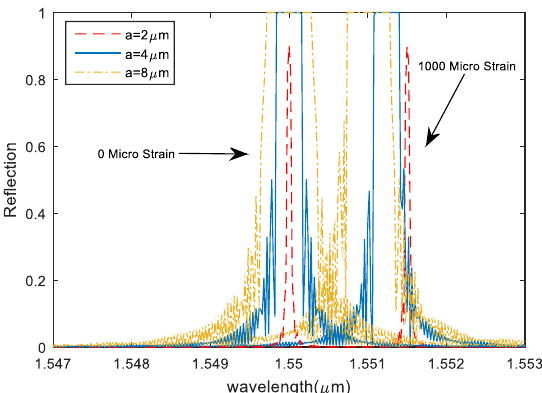
Figure 10: Reflection response in FBG as a function of core radius under 0 and 1000 micro strain.